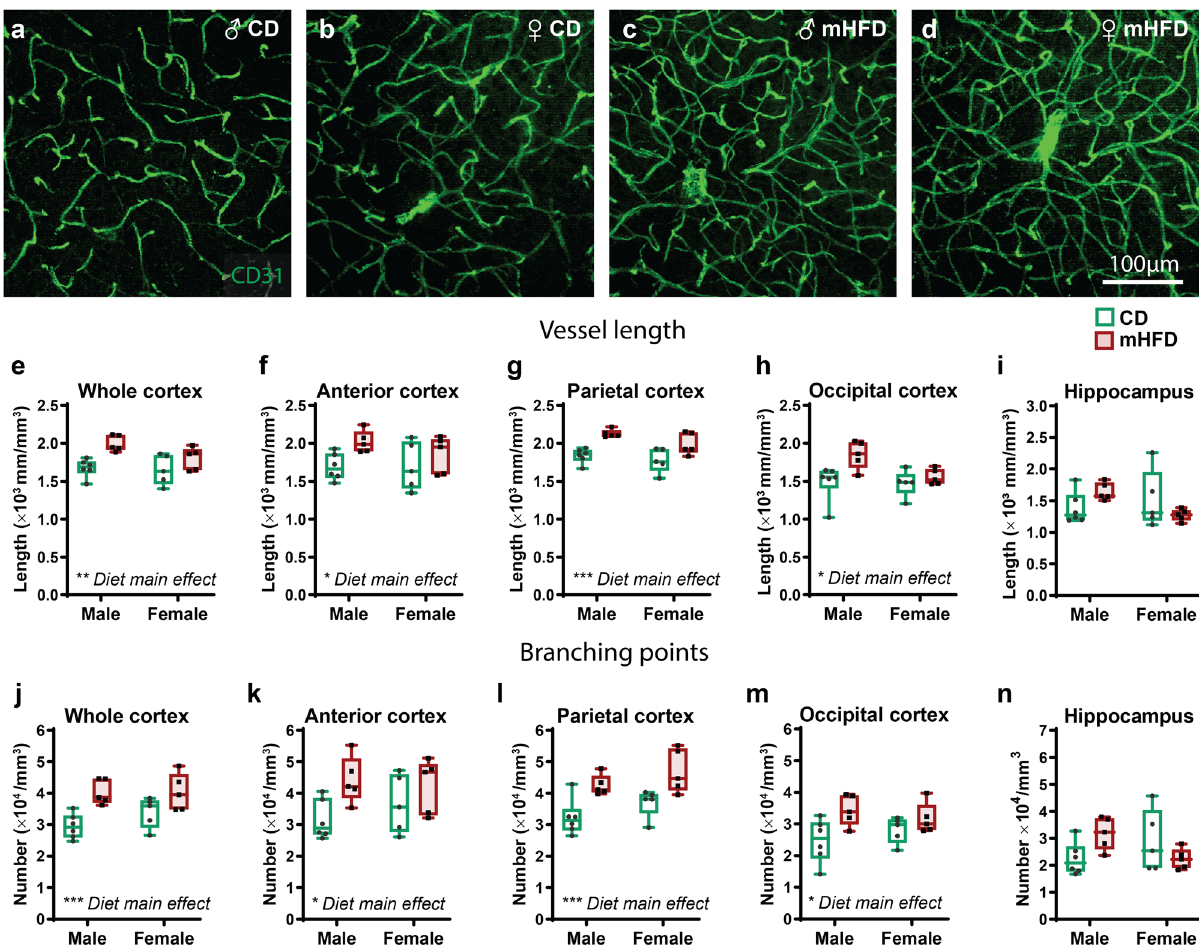
Fig. 1 mHFD promotes increased length and number of branching of cortical blood vessels in P30 offspring. a – d Zoom-in of pictures taken at 20x with an epi fl uorescence microscope illustrate blood vessels organisation and complexity in the parietal cortex of adolescent offspring. e – i Vessel length and ( j – n ) branching points of blood vessels in the ( e , j ) whole cortex, ( f , k ) anterior cortex, ( g , l ) parietal cortex, ( h , m ) occipital cortex, and ( i , n ) hippocampus of the adolescent offspring were increased after exposure to mHFD. Whisker graphs show minimum, median (line) and maximum, as well as individual data points ( n = 5 – 6 animals/diet/sex). * P < 0.05, ** P < 0.01, *** P < 0.001 by 2-way ANOVA analysis (all data, except occipital cortex vessel